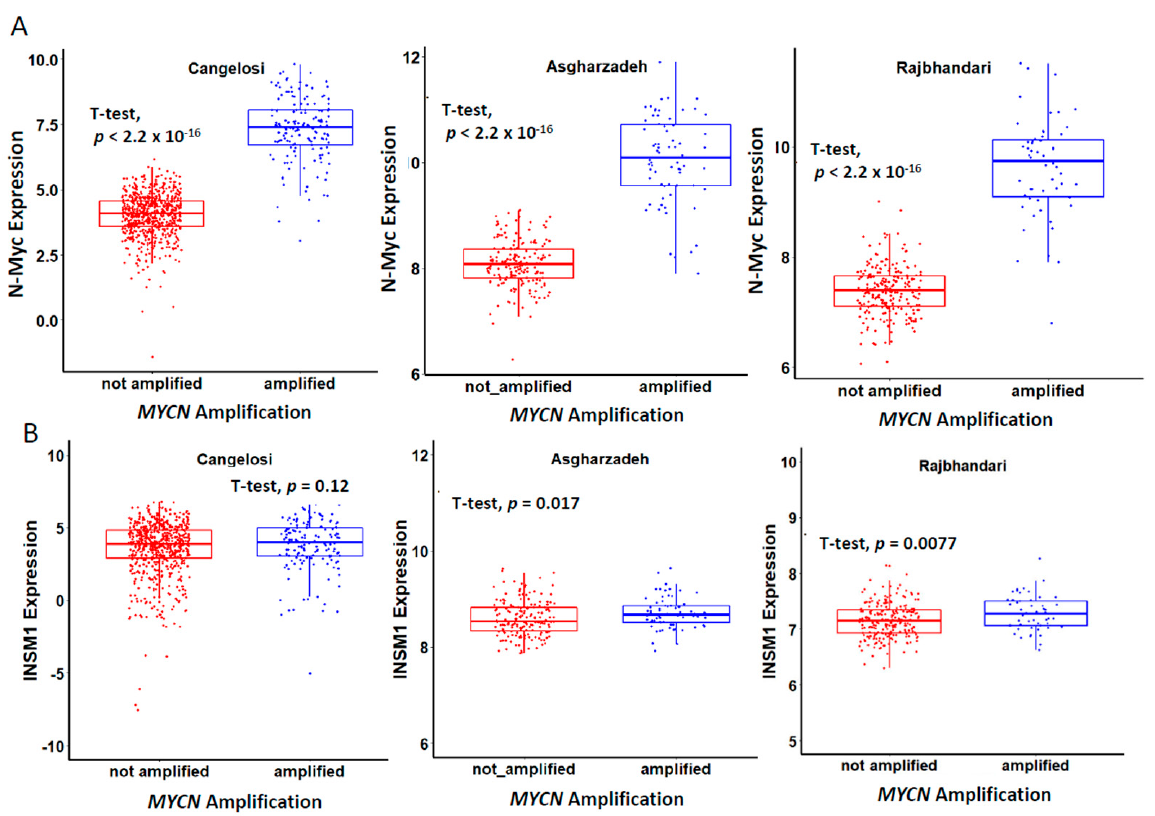
Figure 3. Correlation of N-Myc/INSM1 expression with MYCN gene amplification. ( A ) N-Myc expression positively correlates with MYCN amplification in NE patients derived from three different public cohorts, Cangelosi (782 samples), Asgharzadeh (247 samples) and Rajbhandari (273 samples). ( B ) INSM1 expression significantly correlates with MYCN amplification in NB patients derived from Asgharzadeh (247 samples), and Rajbhandari (273samples) but non-significant in Cangelosi (782samples) cohort.